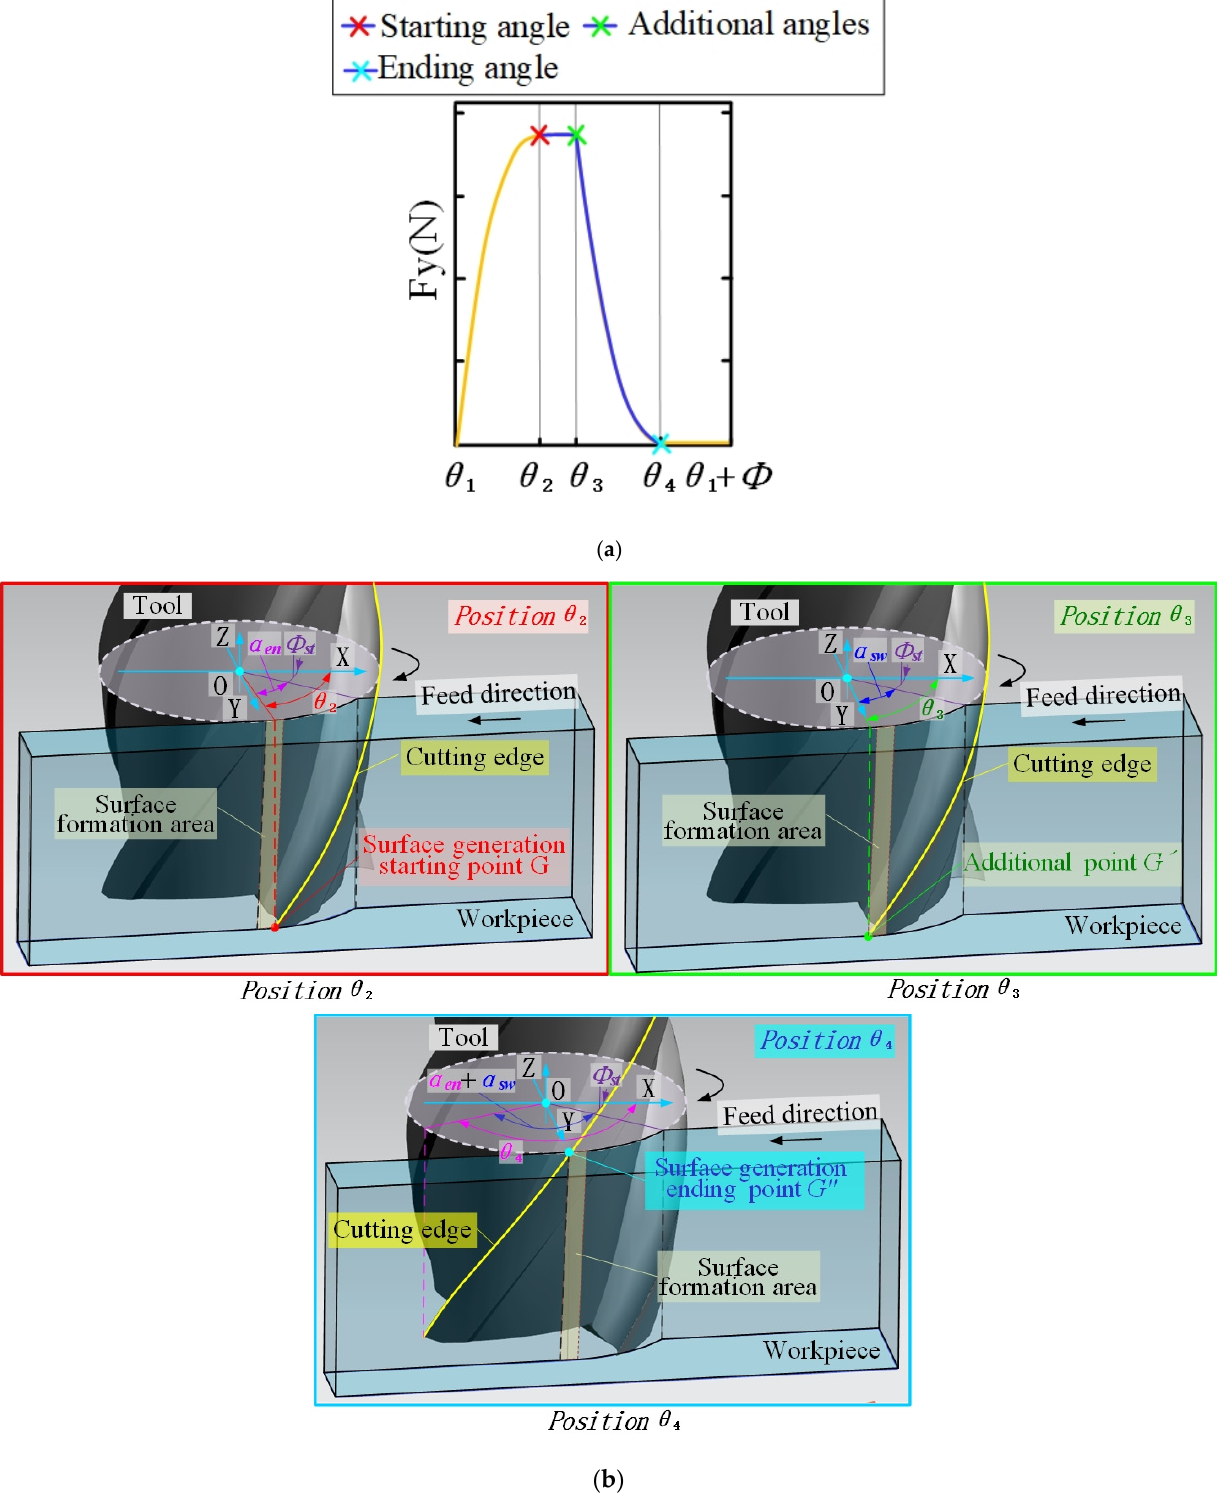
Figure 5. The key angle of surface generation. ( a ) The key angle selection of cutting force. ( b ) Display of key angles. The contact relationship of the tool–workpiece affects the waveform of the force signal, which also affects the surface profile of the workpiece. This correlation is applicable to any side milling process.